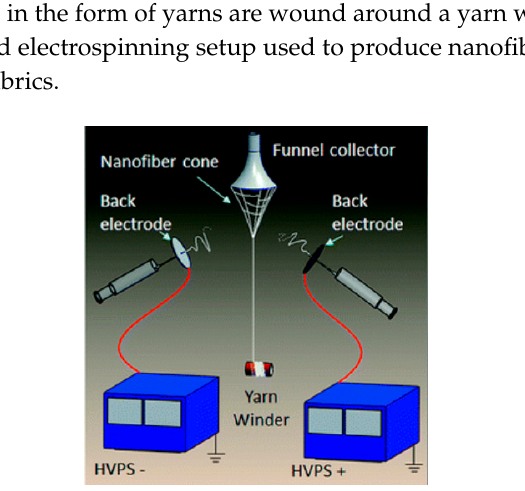
Figure 2. Conjugated electrospinning setup used to produce nanofiber yarns. Reprinted from RSC Advances , Vol. 5, Zhigang Xie, Haitao Niu, Tong Lin, Continuous polyacrylonitrile nanofiber yarns: preparation and dry-drawing treatment for carbon nanofiber production, 15147–15153, Copyright (2015), with permission from Royal Society of Chemistry.